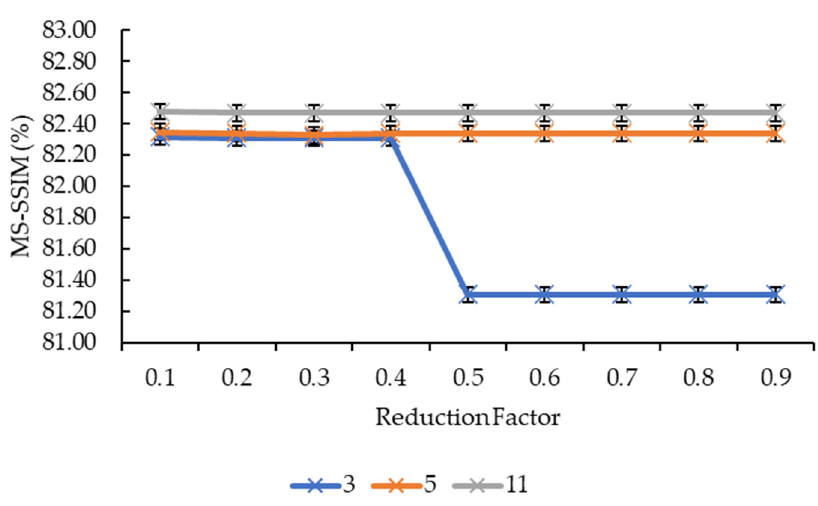
Figure 6. Graph of MS-SSIM against reduction factor.